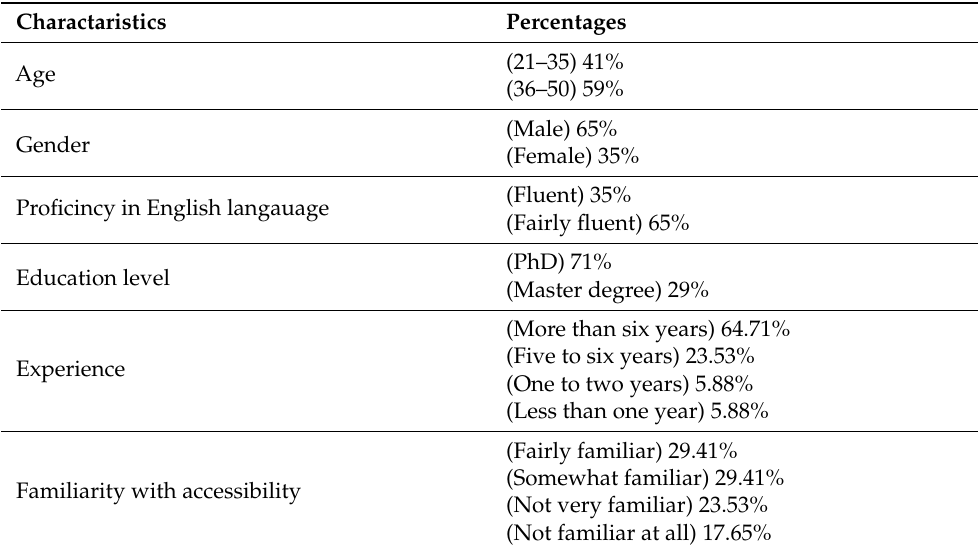
Table 2. Characteristics of